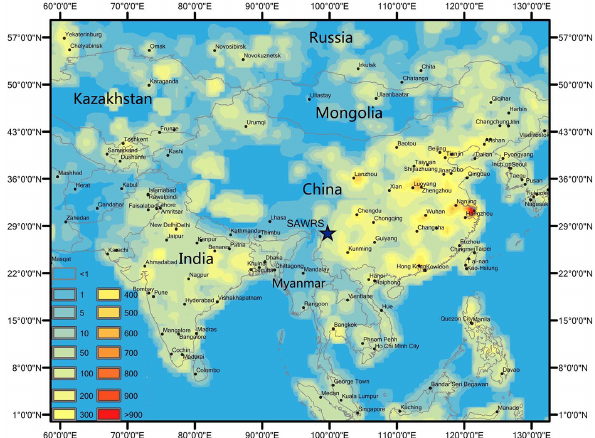
Figure 1. Map showing the location of SAWRS, anthropogenic Hg emissions (gkm − 2 y − 1 ) and major cities in Asia (AMAP/UNEP,